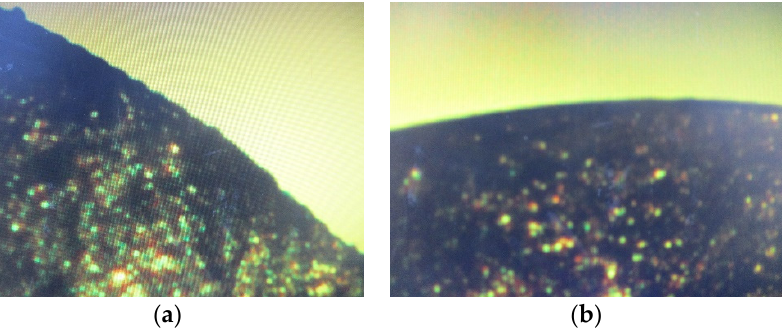
Figure 11. Images of cross-section of micro-asperical lenes ( a ) before polishing and ( b ) after polish- ing.